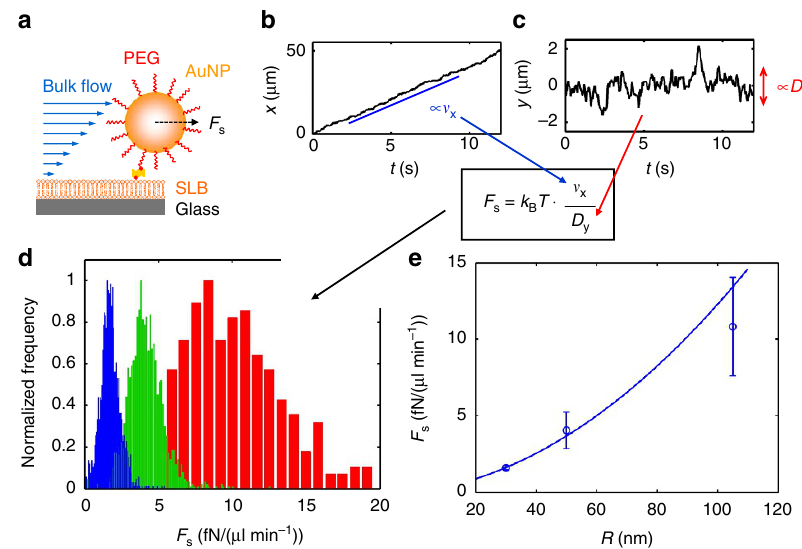
Figure 2 | Calibration using well-defined gold nanoparticles. Streptavidin-functionalized gold nanoparticles ( a ; with a PEG shell thickness of 5nm) are linked to biotinylated lipids (linker length of B 5nm) in the SLB and label-free monitored using surface-enhanced ellipsometric contrast (SEEC) imaging. ( b , c ) give a decomposition of a representative trajectory (30nm gold nanoparticle; 15 m lmin (cid:3) 1 flow rate) into its component in flow direction ( x -axis) and perpendicular to the flow ( y -axis). Due to the flow, the x -component is dominated by a directed movement (indicated by its linear increase with time), allowing to extract the induced velocity v x , while the y -component remains (due to absence of shear force in this direction) fully random and allows to extract the linker diffusion coefficient D y (see Supplementary Note 3 for details). Combining both information yield the hydrodynamic shear force F s acting on the particular nanoparticle. Histograms ( d ) of F s (after normalization to the flow rate) exhibit a peak at 1.60fNmin m l (cid:3) 1 for 30nm (blue), at 4.05fNmin m l (cid:3) 1 for 50nm and at 10.83fNmin m l (cid:3) 1 for 105nm gold nanoparticles (hydrodynamic radius). These calibration measurements allowed to fit equation (5) ( e ), which is required to convert distributions of the hydrodynamic force into size distributions. The solid line in e gives the result of a weighted least squares fit that also takes the standard deviation of the F s distribution (error bars) into account and yields l ¼ 24.4nm and A Z ¼ 1fNmin m l (cid:3) 1